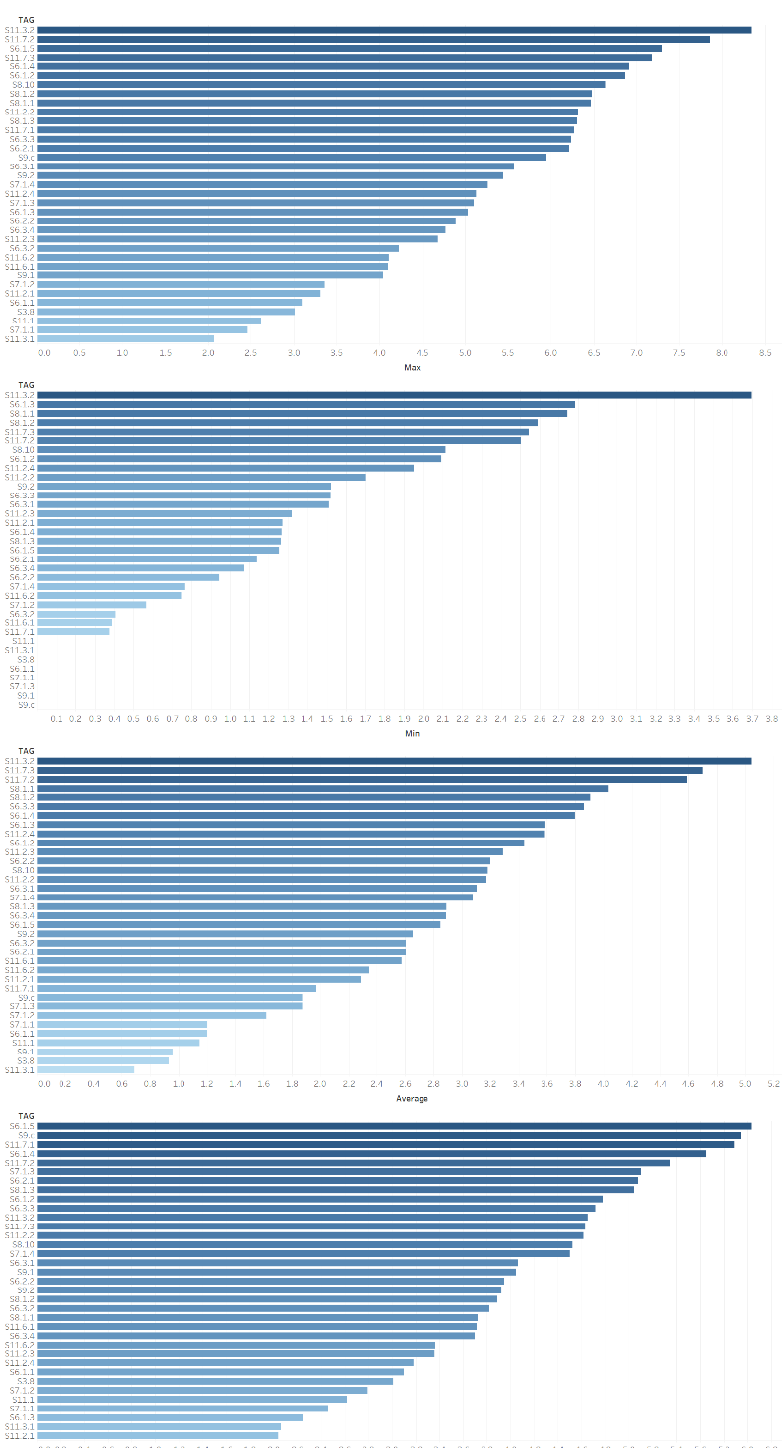
Figure 2. The order of indicators based on AWD under four statistical standards.